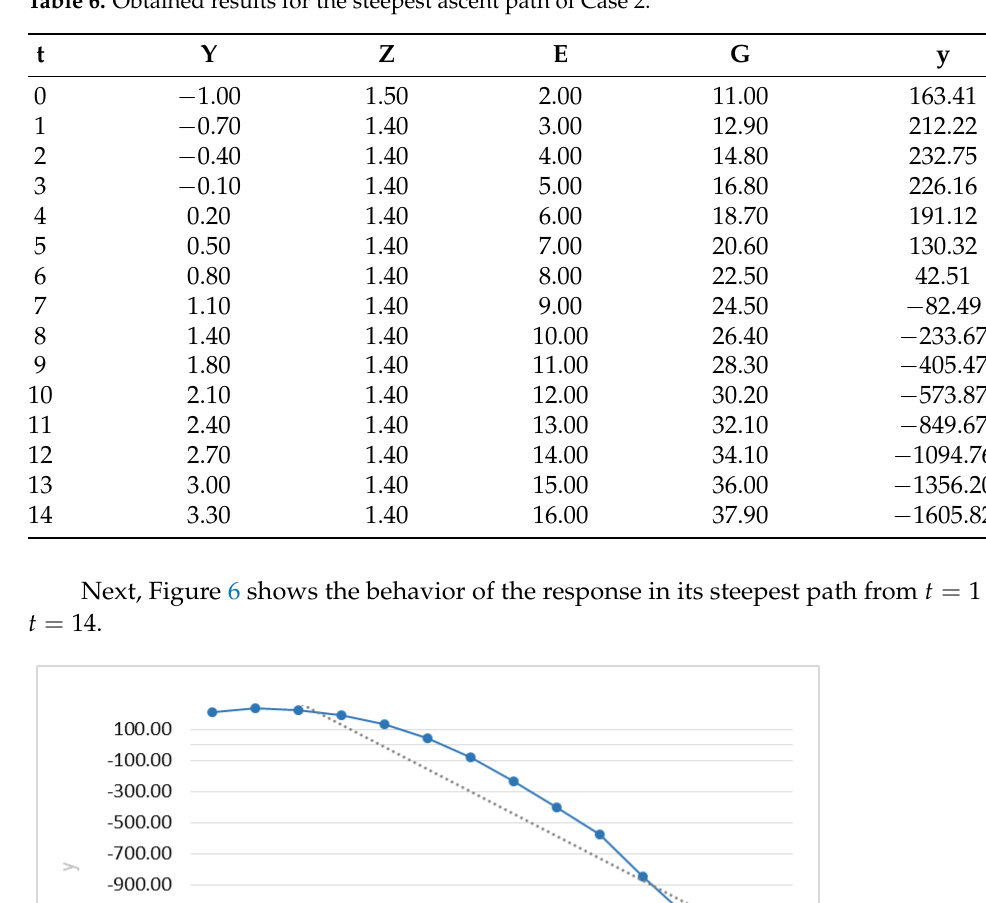
Table 6. Obtained results for the steepest ascent path of Case 2.